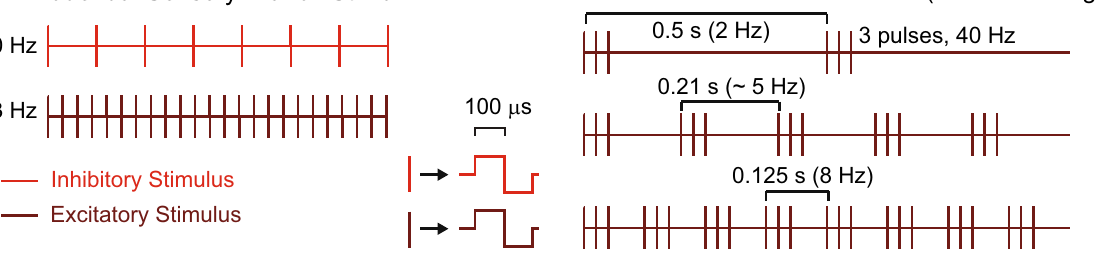
Figure 1. Patterns of state-dependent electrical stimulation to restore bladder function. ( a ) Example cystometrograms (male cat) showing bladder pressure (black) and voided volume (blue) during bladder filling and emptying without stimulation, during continuous stimulation to inhibit the bladder and promote continence, and during state-dependent stimulation to restore both continence and efficient bladder emptying. Bladder capacity (BC) and voiding efficiency (VE) for each trial are listed above the traces. ( b ) Stimuli were applied to the pudendal sensory branch (red) to inhibit the bladder and promote bladder storage. Stimuli were applied to either the pudendal motor branch (brown) or the pudendal sensory branch (33 Hz, cats only) to activate the bladder and promote bladder emptying. Excitatory stimuli, 33 Hz stimulation, 2 Hz motor bursting, and 5 Hz motor bursting are based on previous studies 9,10 with an additional 8 Hz motor bursting pattern added for